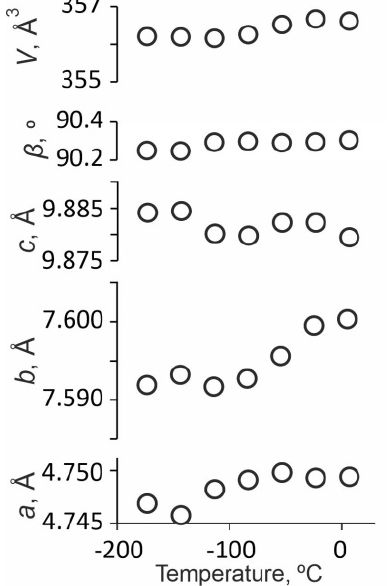
Figure 7. The unit ‐ cell parameters of hingganite ‐ (Y) at different temperatures. The errors are smaller Figure 7. The unit-cell parameters of hingganite-(Y) at di ff erent temperatures. The errors are smaller than symbols. than